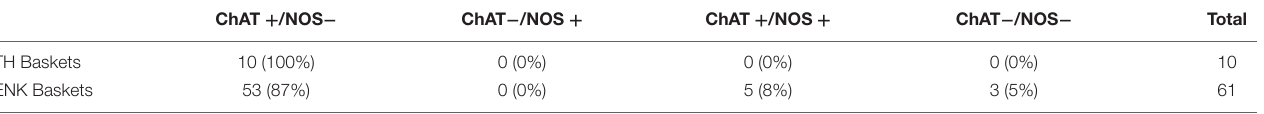
TABLE 2 | Visually defined TH and ENK baskets surrounding myenteric plexus human RNA binding proteins C and D (HuC/D) cells. ChAT + /NOS − ChAT − /NOS + ChAT + /NOS + ChAT − /NOS −